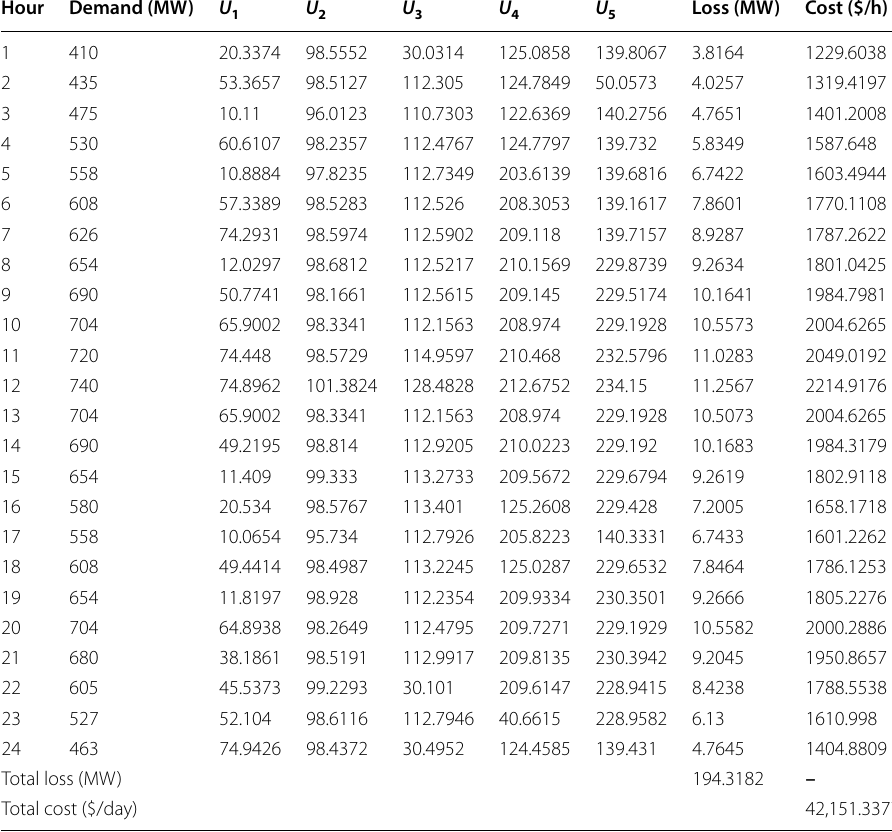
Table 5 Best fuel cost obtained by using HPSTCO for 5-unit system